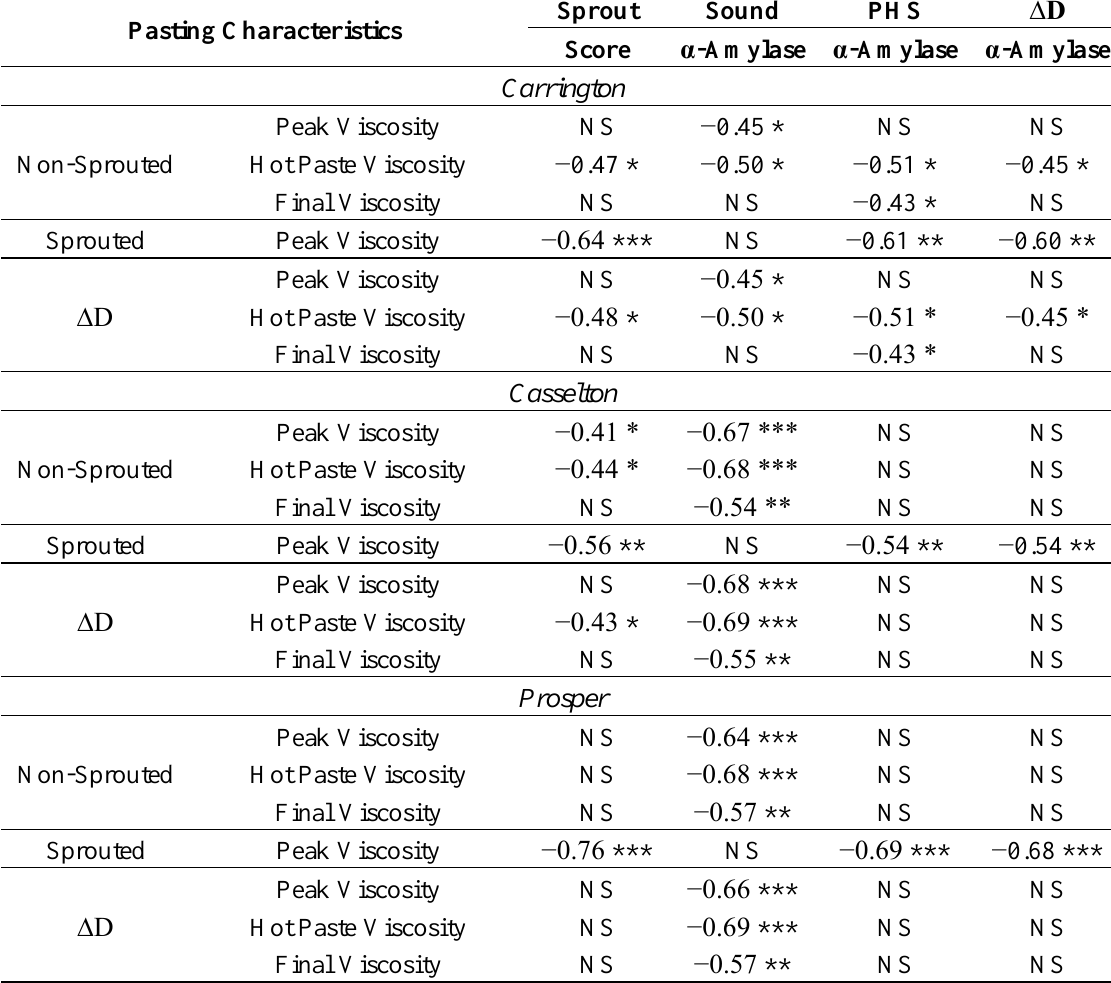
Table 3. Correlation coefficients a between α-amylase activity and pasting characteristics among 24 genotypes from Carrington, Casselton and